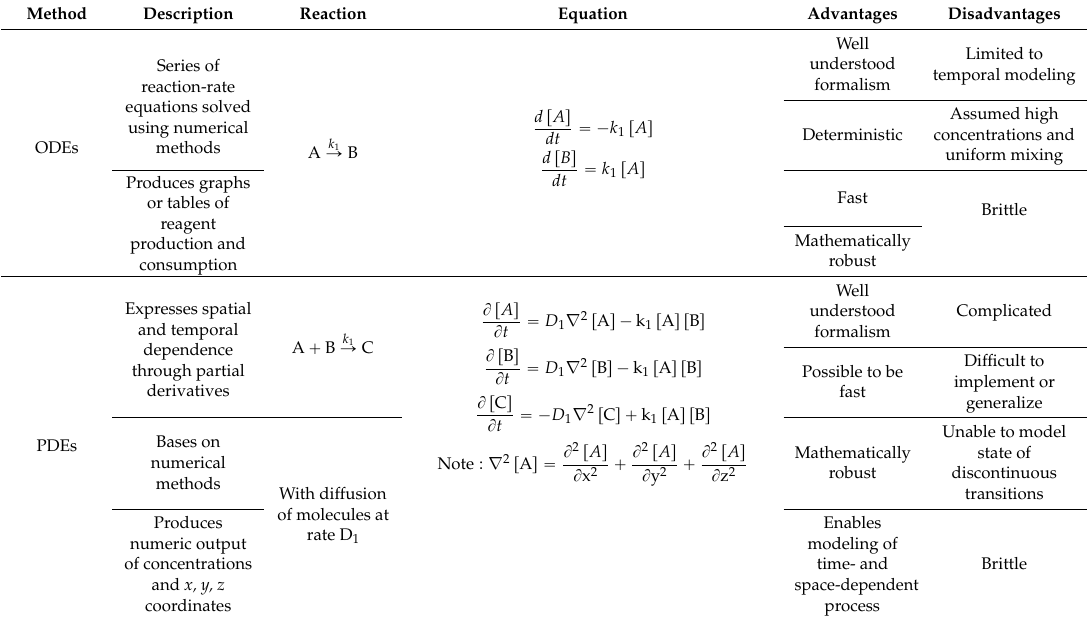
Table 3. Summary of different methods used in dynamic